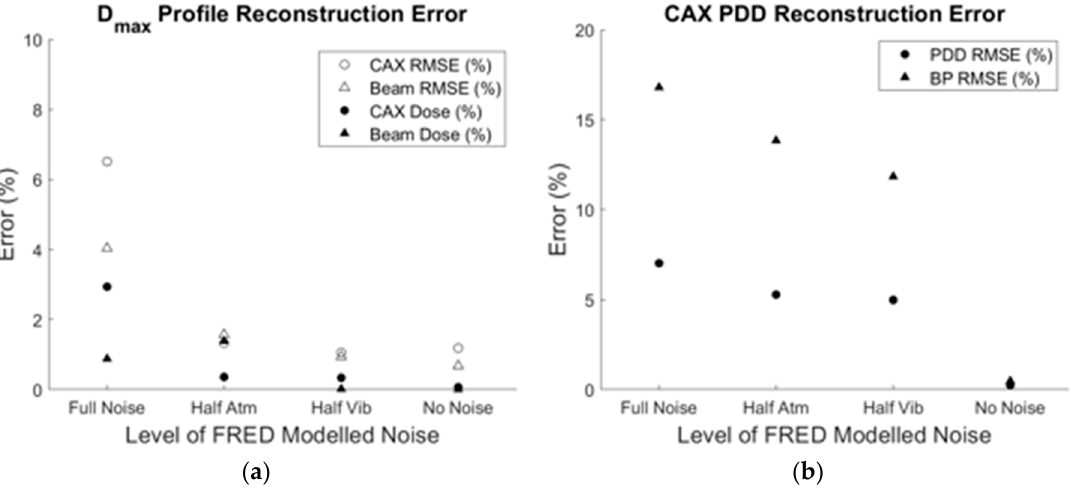
Figure 10. Comparison of reconstruction error metrics for different level of modelled noise. The D max profile RMSE (%) and mean dose difference (%) for the CAX and beam regions ( a ) and CAX PDD RMSE (%) and BP RMSE (%) ( b ) are given for the inverse Abel transform tomographic reconstruction of full-noise, half-atmospheric turbulence, half-vibration, and no-noise virtual DHI-based OC dosimeter simulations. The error metrics were calculated through comparison with the original MC-simulated 3D dose distribution.